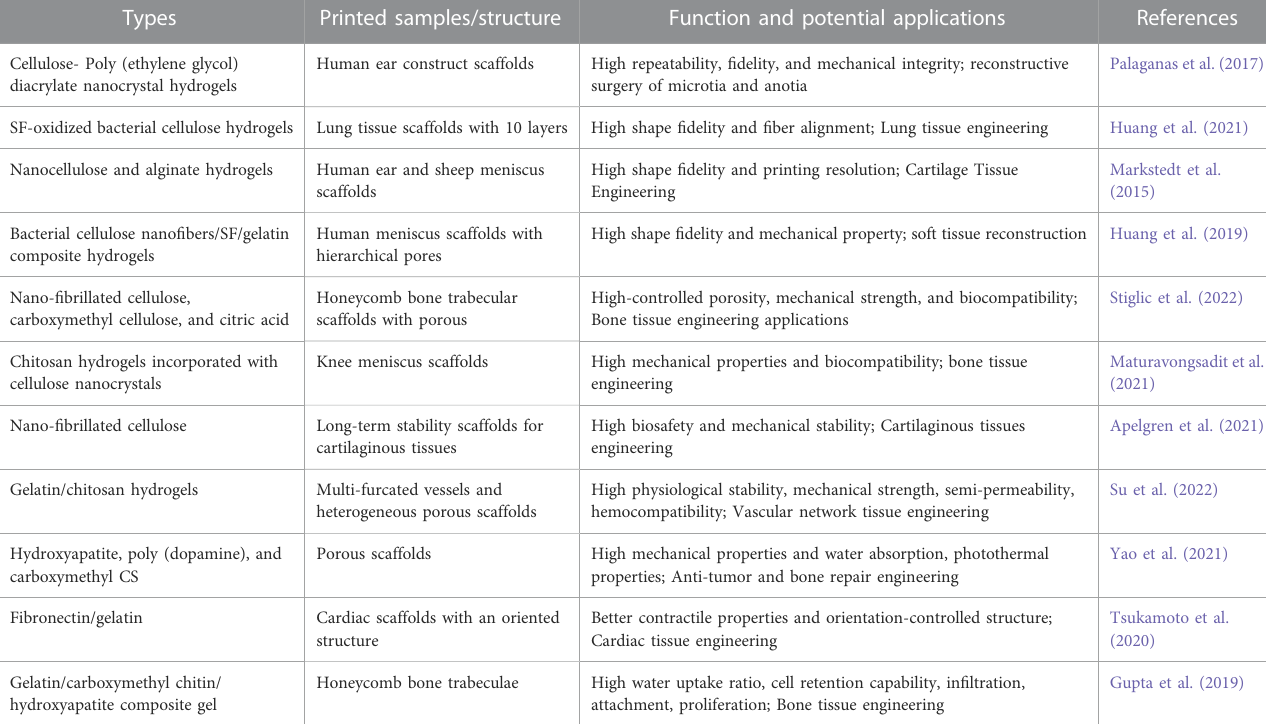
TABLE 2 The 3D printing of biomass polysaccharide fi ber materials in medical